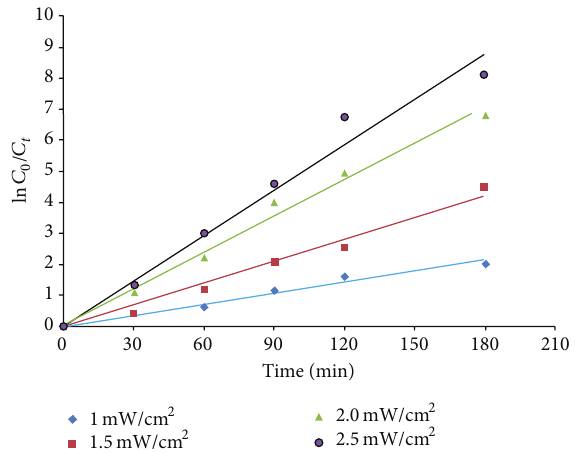
Figure 5: Effect of light intensity on the degradation rate of Anthracene.